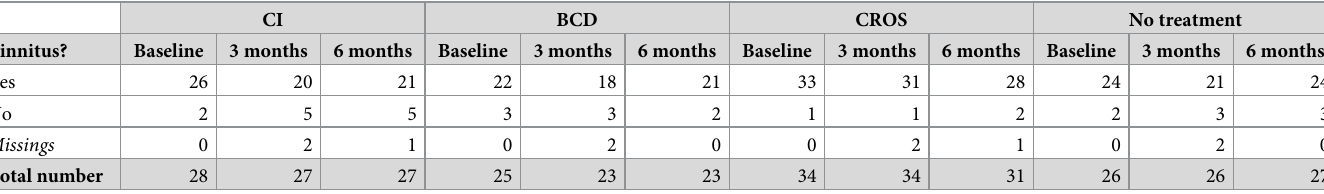
Table 2. Number of patients with and without tinnitus per group per follow-up moment.